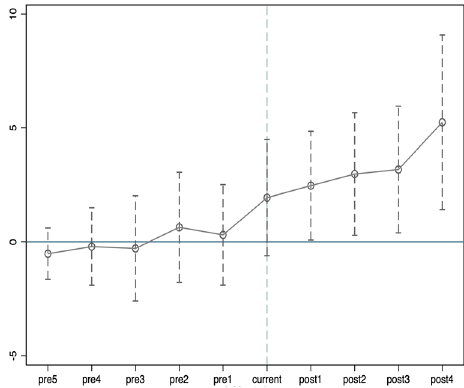
Figure 1. Parallel trend test. Table 3. Parallel trend test.